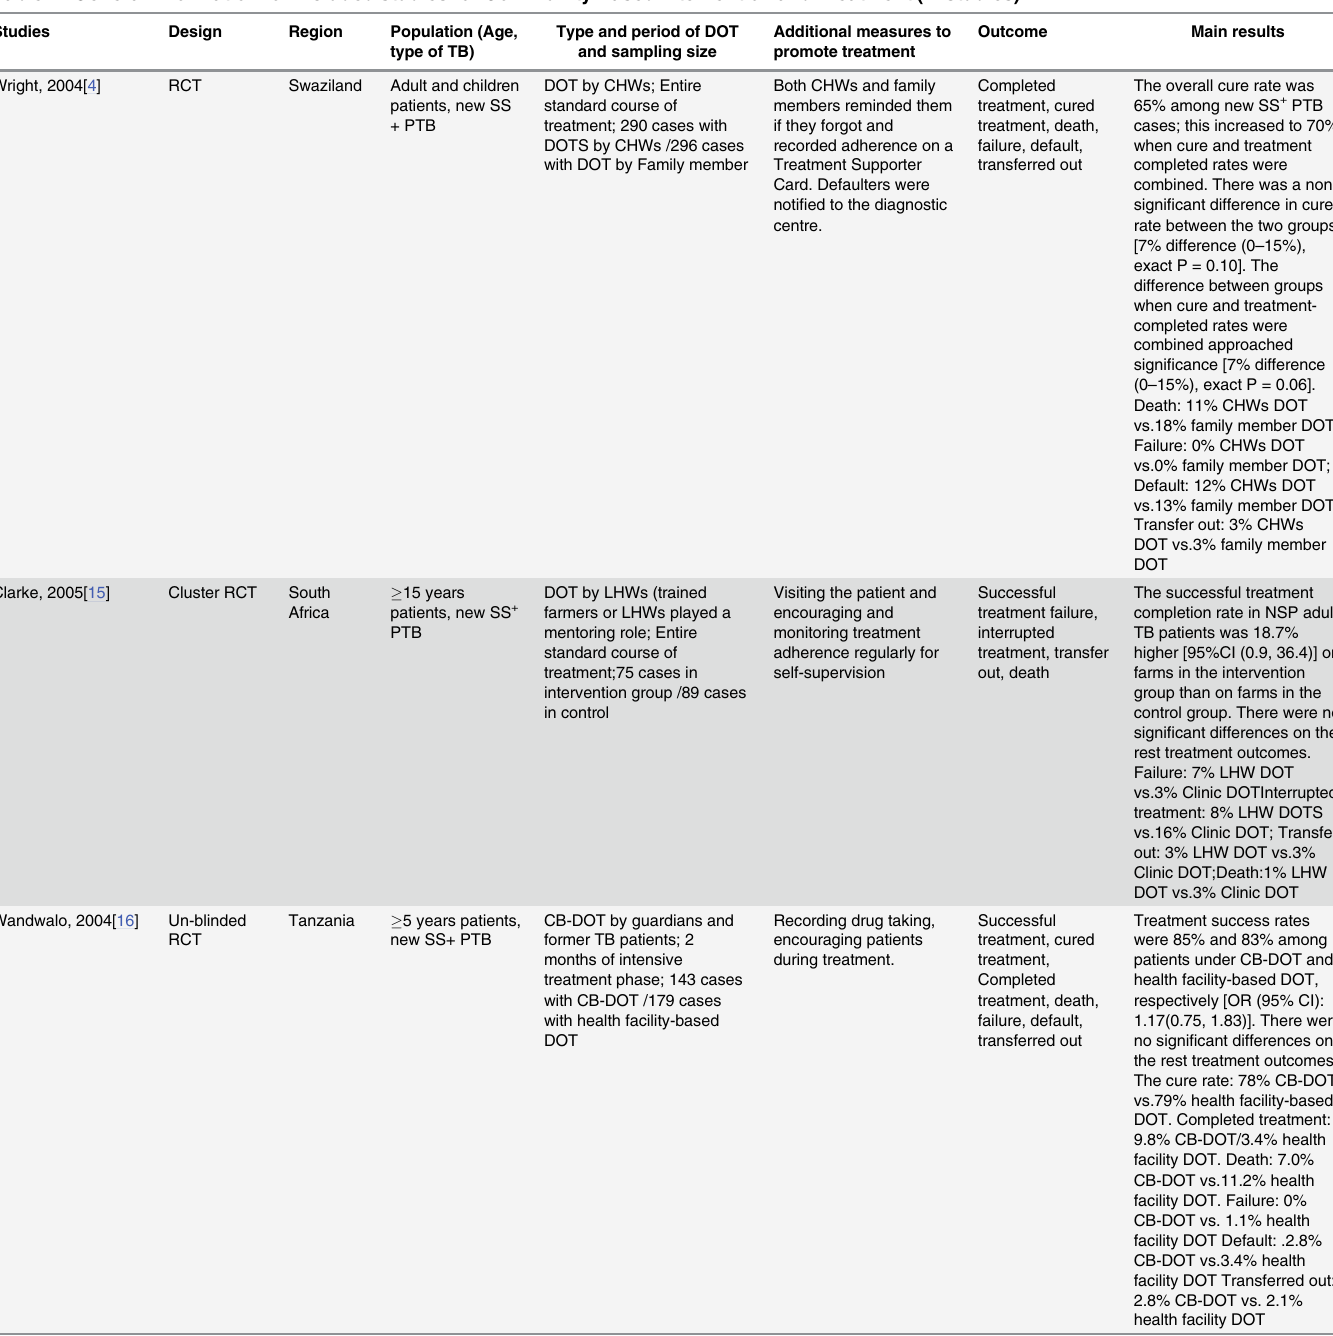
Table 1. General information for included studies for Community Based intervention and Treatment